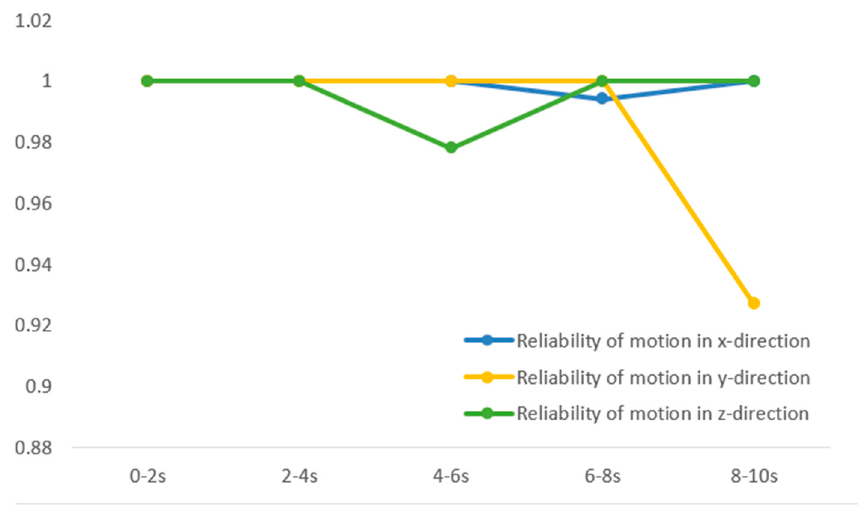
Figure 20. Non ‐ probabilistic reliability of robot motion at different time periods. Figure 20. Non-probabilistic reliability of robot motion at different time